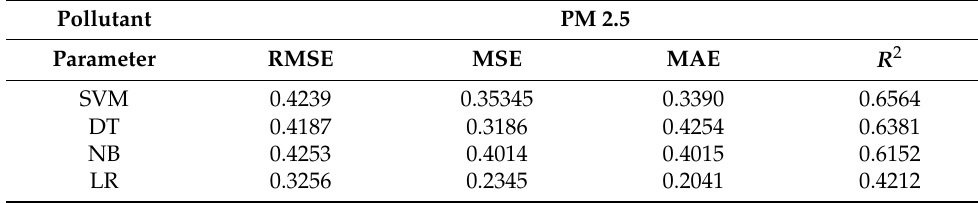
Table 5. Error comparison for PM 2.5.